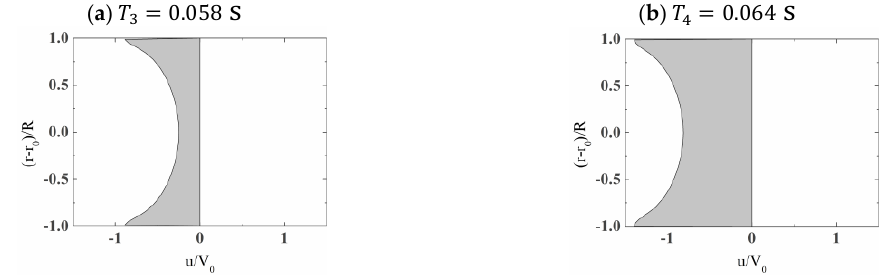
Figure 13. Axial velocity distribution at different time ( 𝑇 3 = 0.058 s and 𝑇 4 = 0.064 s ) of the S1 monitoring point.